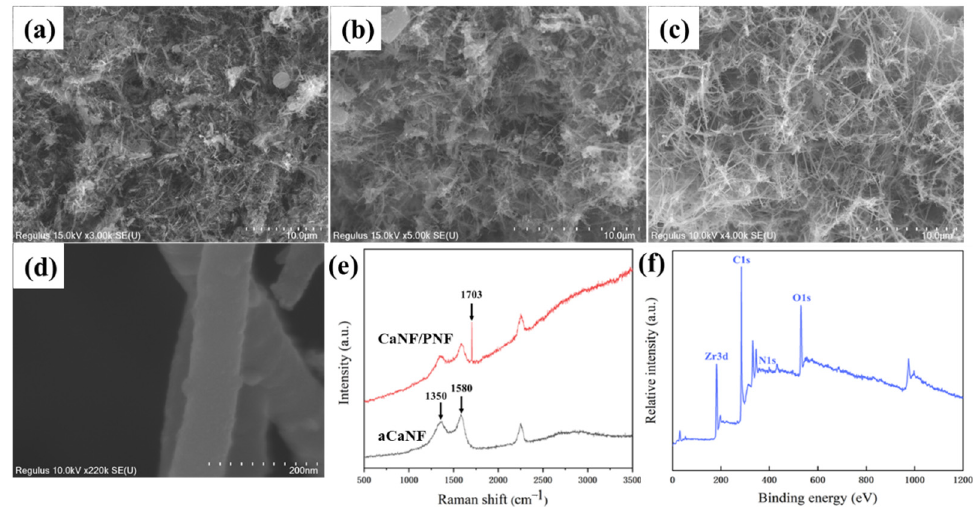
Figure 6. ( a – c ) SEM images of the organic-inorganic hybrid membranes with PNFs amount of ( a ) 0.125, ( b ) 0.25, and ( c ) 0.5 mg. ( d ) Enlarged SEM image of the membrane, ( e ) Raman spectra of aCaNF and CaNF/PNF membranes, and ( f ) XPS spectrum of the biomimetic CaNF/PNF-ZrO 2 membrane.